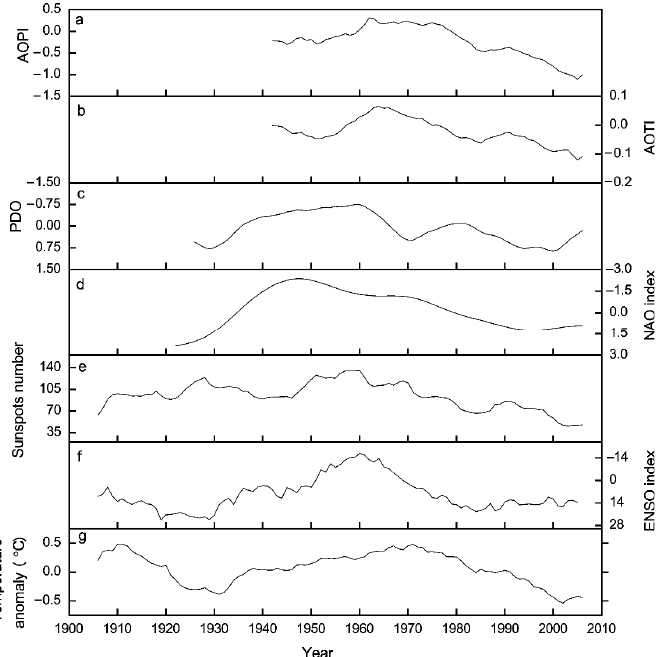
Figure 10. A comparison of the AOPI ( a ), AOTI ( b ), PDO ( c ), NAO index ( d ), sunspot number ( e ), ENSO index ( f ) and the reconstructed T DS in this study ( g ). All curves are smoothed by an 11-year moving average.